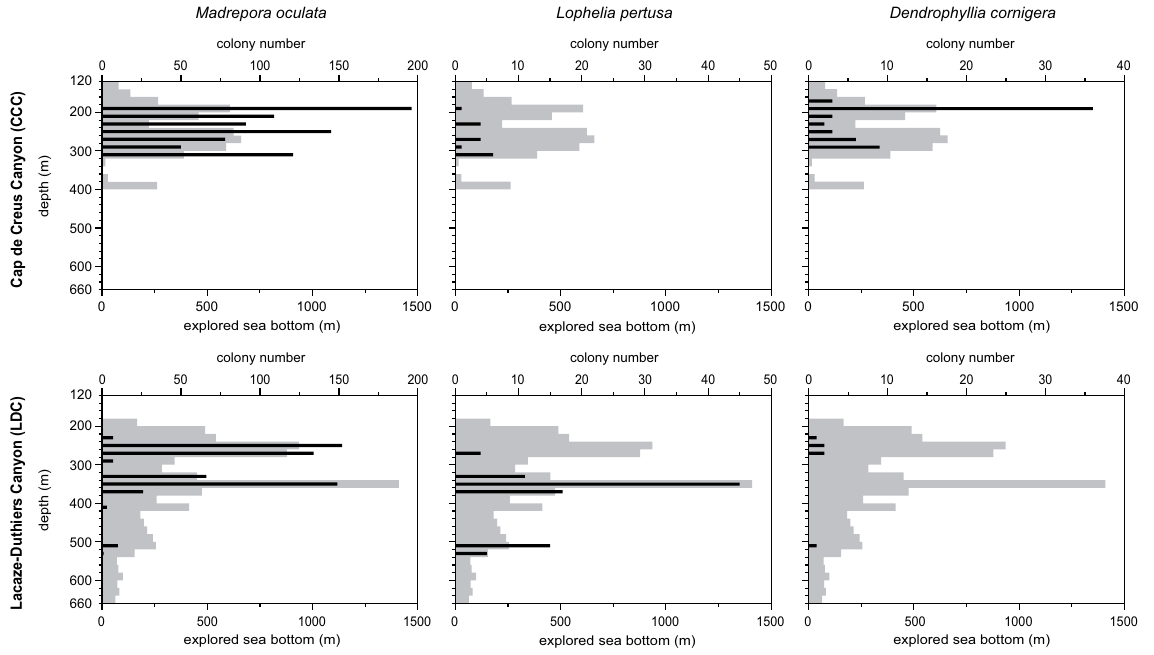
Fig. 3. Bathymetrical distribution of the Madrepora oculata , Lophelia pertusa and Dendrophyllia cornigera colonies in the Cap de Creus Canyon (CCC) and the Lacaze-Duthiers Canyon (LDC): the black line indicates the number of colonies; grey-scale histograms represent the explored sea bottom (m) over the studied bathymetrical range. Table 2. Location and characteristics of transects in the Cap de Creus Canyon (CCC) and Lacaze-Duthiers Canyon (LDC); number of observed colonies is indicated for each species and in each